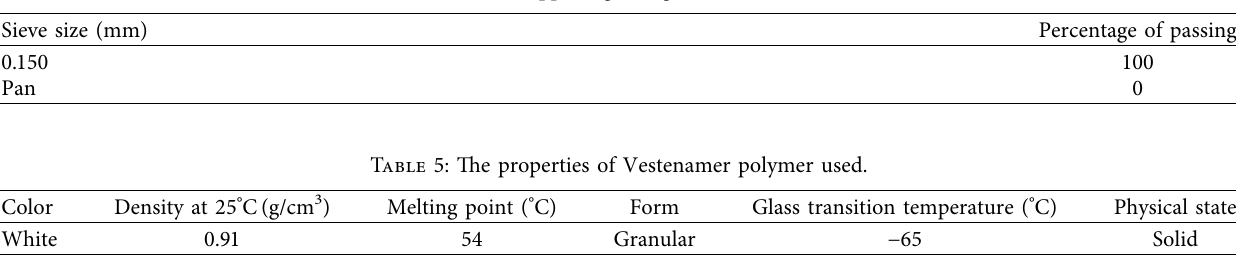
Table 4: Applied grading of CRP used.